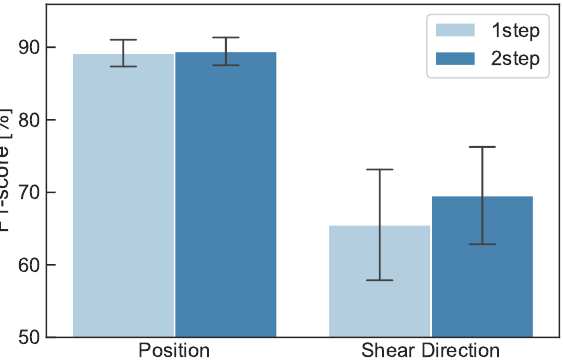
Figure 10. F1 score of one-step recognition and proposed methods (%).